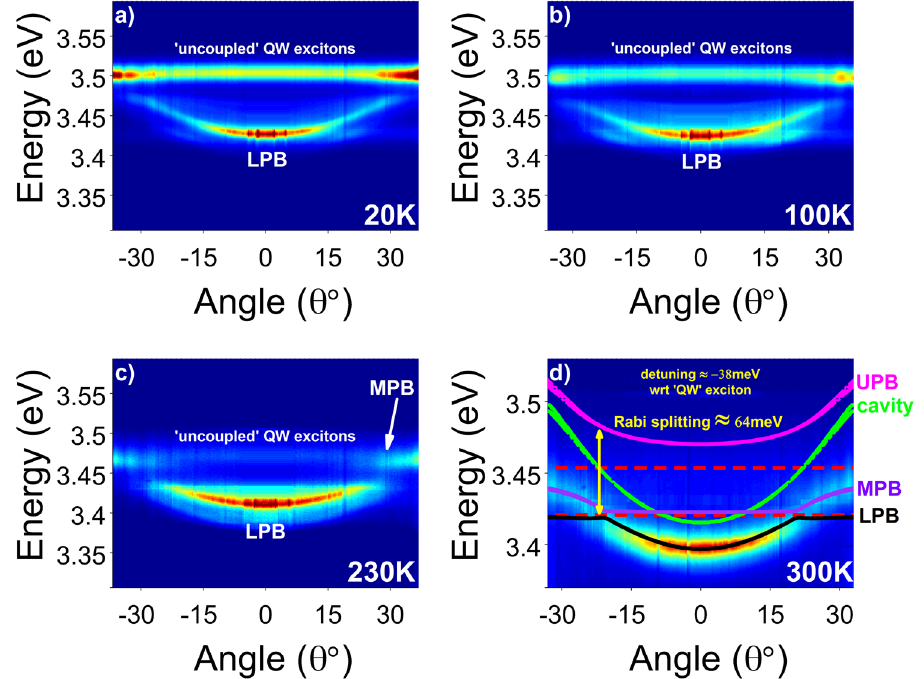
Figure 2. Angle-dependent polariton photoluminescence recorded at various temperatures. ( a ) 20 K, ( b ) 100 K, ( c ) 230 K, and ( d ) 300 K. Emission from the LPB and MPB dispersions, as well as the uncoupled QW excitons, are indicated. Simulated data for LPB, MPB, UPB and cavity mode are presented as solid lines, while the corresponding exciton levels in the QWs and the GaN spacer, as dashed lines. Data obtained from membrane